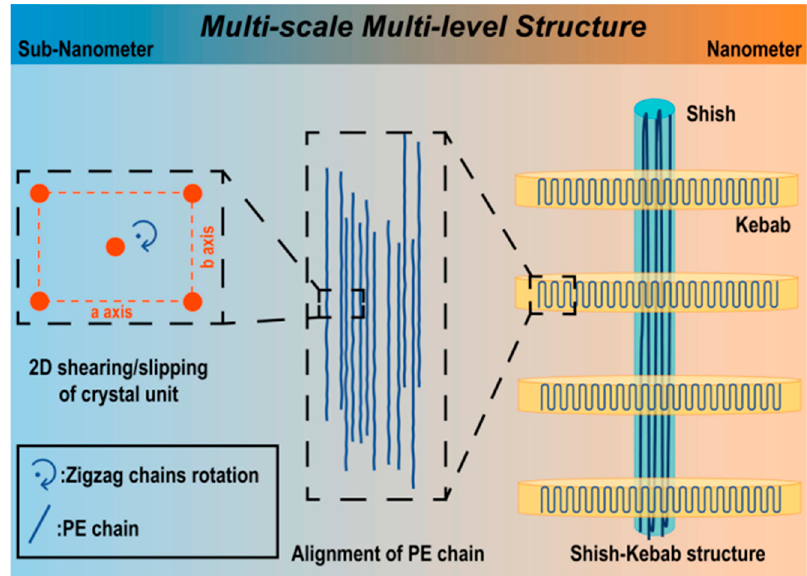
Figure 9. Schematic illustration of PE/UHMWPE prepared under elongational flow. Reproduced with permission from [52]. Copyright 2020, American Chemical Society.